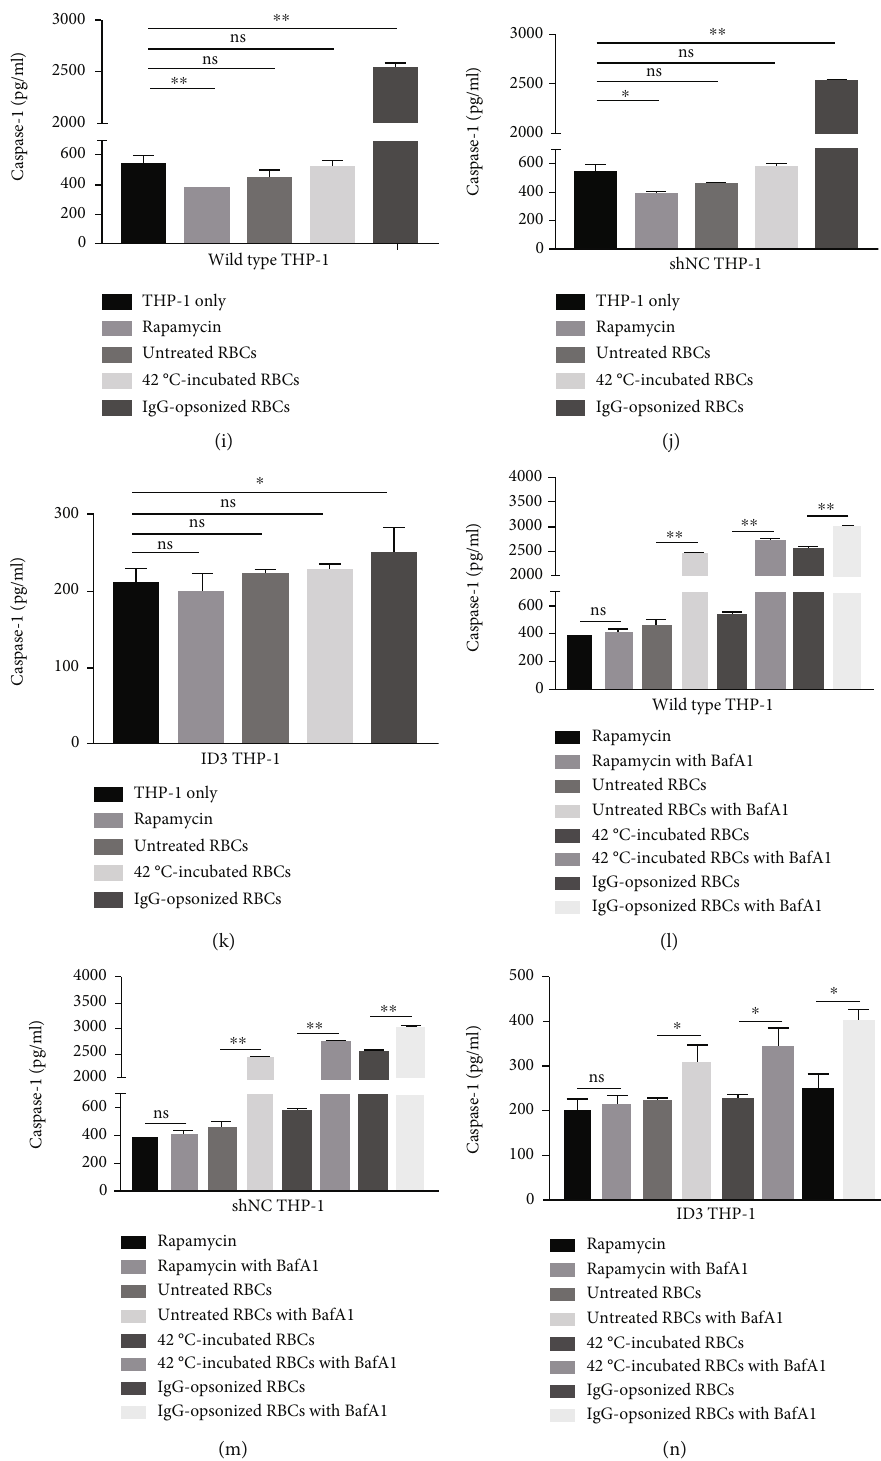
Figure 7: The amounts of IL-1 β and caspase-1 detected by ELISA. (a) The concentrations of IL-1 β of three di ff erent THP-1 cells after receiving the same stimulation in nine groups. (b) The concentrations of caspase-1 of three di ff erent THP-1 cells after receiving the same stimulation in nine groups. (c) – (e) The concentrations of IL-1 β of wild-type, shNC, and ID3 THP-1 cells after phagocytosis of erythrocytes. (f) – (h) Regulatory e ff ect of BafA1 on IL-1 β secretion. (i) – (k) The concentrations of caspase-1 of wild-type, shNC, and ID3 THP-1 cells after phagocytosis of erythrocytes. (l) – (n) Regulatory e ff ect of BafA1 on caspase-1 expression. ∗ p < 0 : 05 , ∗∗ p < 0 : 01 , and ns: not signi fi